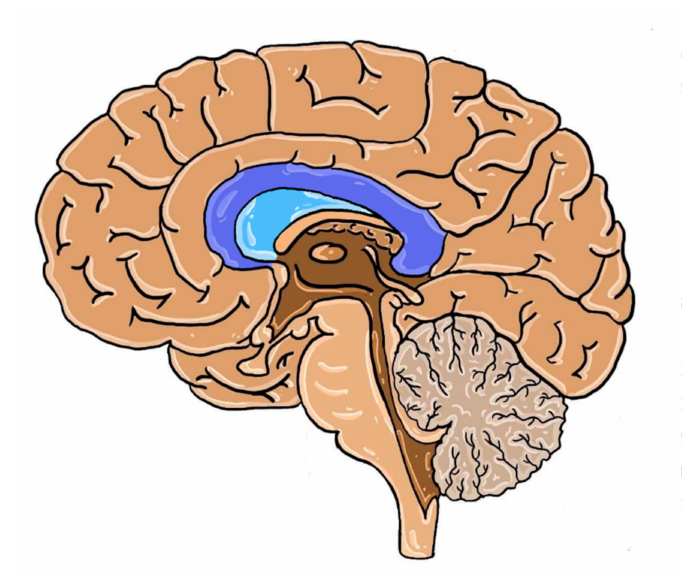
Figure 1. The structures of the human brain in the median plane. Dark blue: corpus